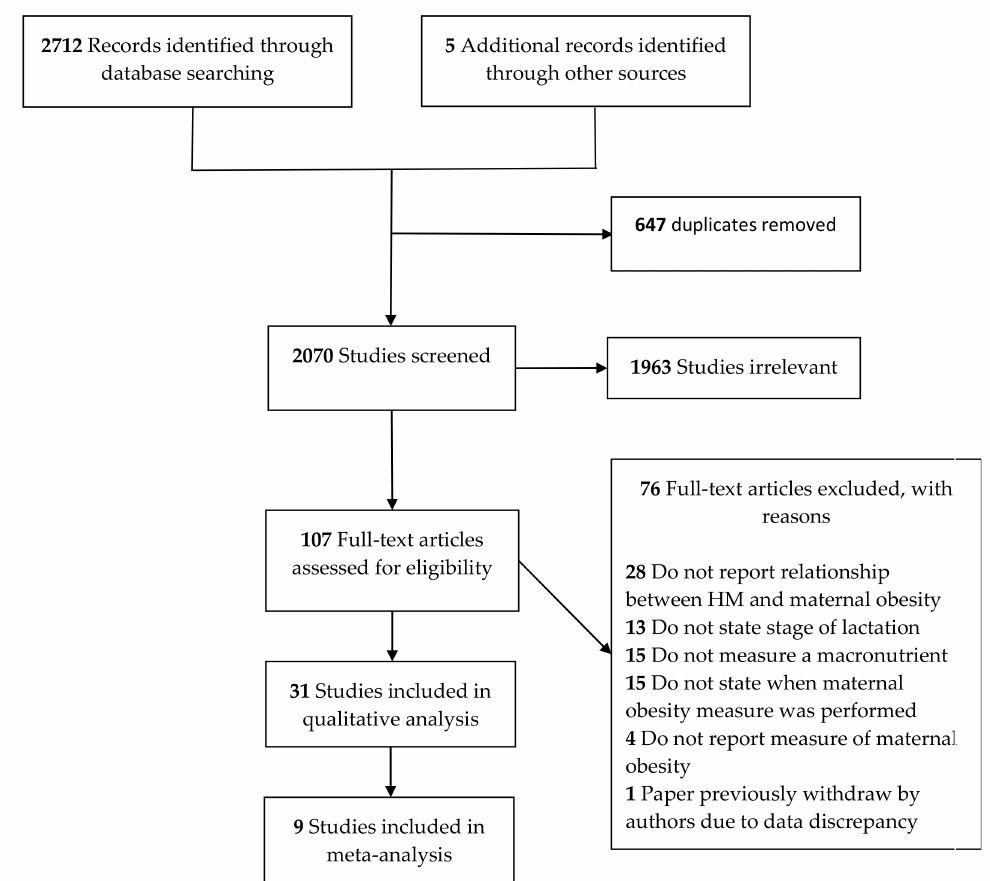
Figure 1. Preferred Reporting Items for Systematic Reviews and Meta-Analysis (PRISMA) flow diagram highlighting the process of article screening and reasons to